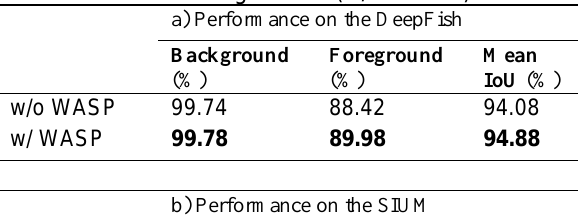
Table 3. Comparison between the fish